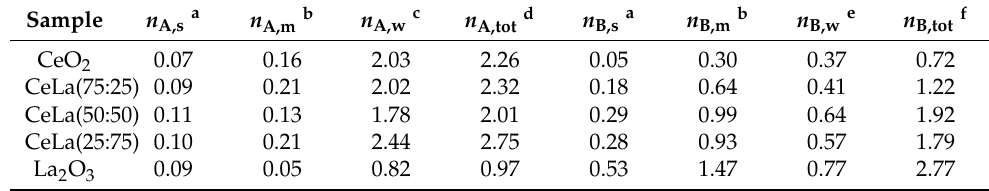
Table 2. Amount of acid ( n A ) and basic ( n B ) sites ( µ mol m − 2 ) for the synthesized oxide